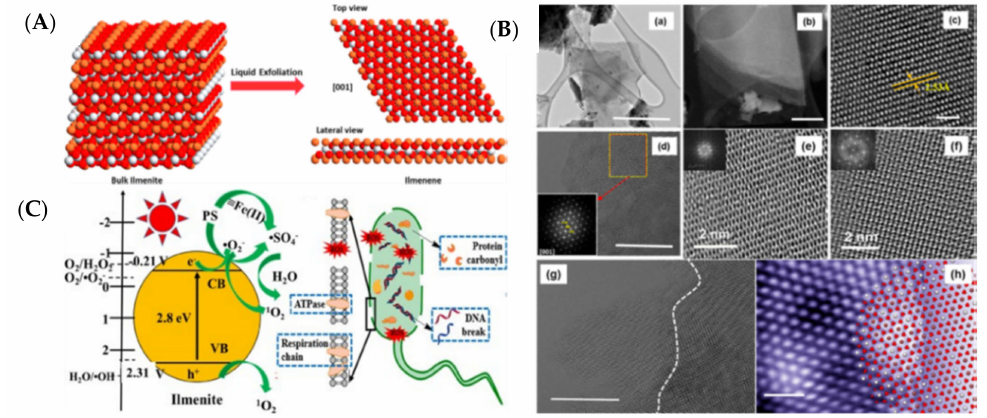
Figure 11. ( A ) Liquid exfoliation of bulk ilmenite (left) into the most stable [001] oriented 2D monolayers (right). A planar view (right top) and a cross-sectional view (bottom right) of the monolayer are shown. White, brown, and red colors denote Ti, Fe, and O atoms, respectively; ( B ) 2D morphology: ( a ) bright-field TEM images (scale bar of 0.5 µ m) showcasing monolayer and bilayer ilmenene sheets; ( b ) dark-field TEM images (scale bar of 0.2 µ m) of a multilayer stack of ilmenene sheets; ( c ) HRTEM image (scale bar of 1 nm). Interplanar spacing of 2.53 Å, corresponding to the (112–0) and (2–110) lattice spacing of the ilmenite structure signifying the (001) plane; ( d ) HRTEM image (scale bar of 10 nm) with a Fourier transform in the inset; ( e , f ) HRTEM image (scale bar of 2 nm) of the (001) ilmenene plane with corresponding Fourier transforms in the inset; ( g ) TEM image (scale bar of 10 nm) showing misaligned stacks of ilmenene sheets; ( h ) HRSTEM image (1 nm) showing individual constituent atoms at (001) ilmenene sheets (brown for Fe, white for Ti, and red for O); ( C ) Plausible mechanism of photocatalytic inactivation of E. coli On the ilmenite/persulfate (PS) composite under visible light irradiation. Adapted with permission from Ref. [267]. Copyright 2018, American Chemical Society; Adapted with permission from Ref. [271]. Copyright 2018, Elsevier